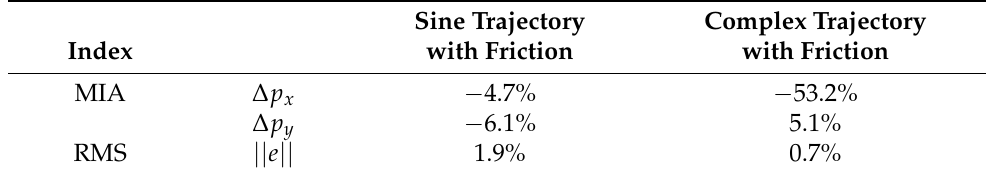
Table 6. IQV tracking performance vs. original algorithm